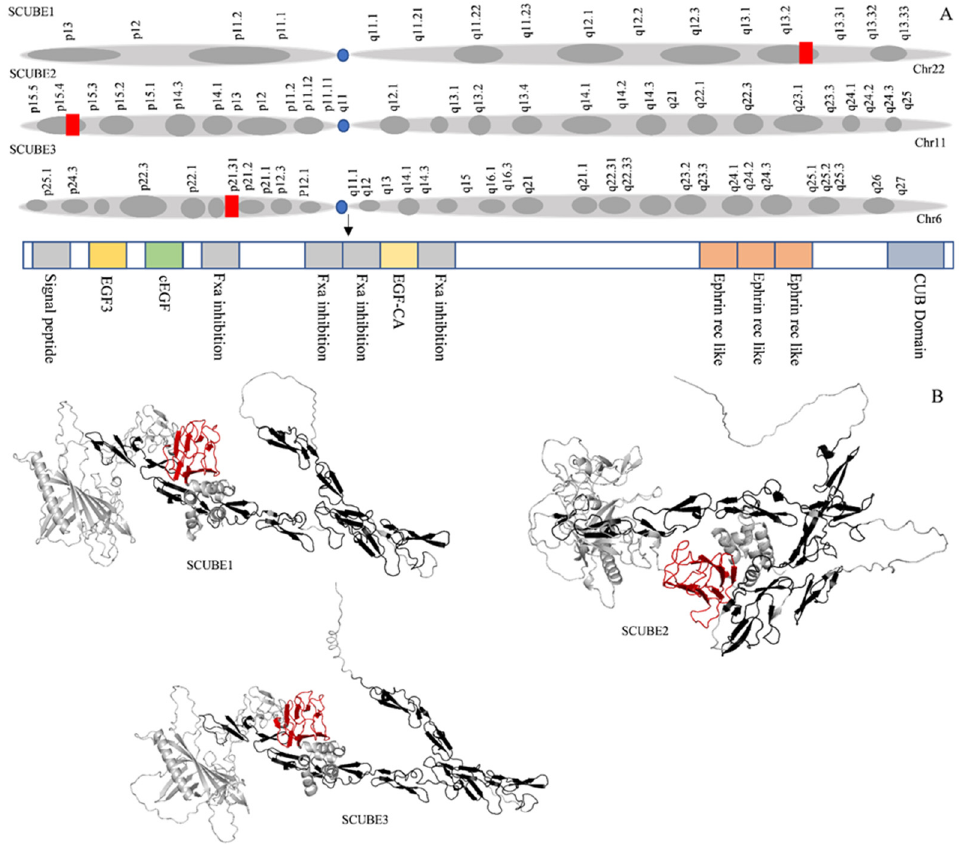
Figure 1. ( A ) Location of SCUBE1, SCUBE2, and SCUBE3 on their respective chromosomes and common arrangement of structural domains in SCUBE proteins. SCUBE family proteins as surface glycoprotein. They are composed of an N-terminal region, signal peptide sequence (SPS), nine EGF- like repeats (E), a spacer region (SR), three cysteine rich repeats (CR), a CUB domain, and a C-terminal region. ( B ) Structural discrepancy of SCUBE family protein. Grey represents whole protein structure, black EGF-like repeats-Ca binding site, and red is the CUB domain.